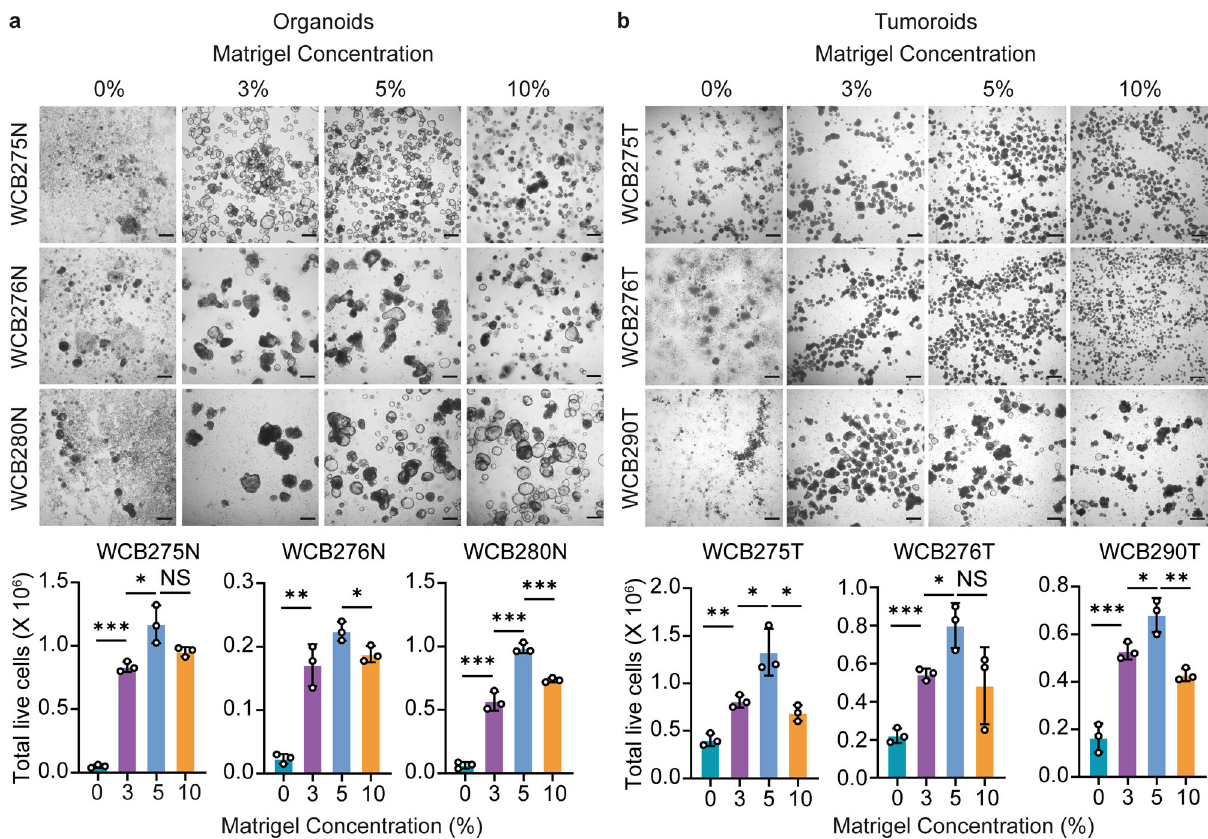
Fig. 1 Low-percentage, low-viscosity Matrigel for suspension culture of patient-derived colorectal organoids and tumoroids. a – b Representative bright- fi eld images and quanti fi cation of live-cell yield for ( a ) organoids and ( b ) tumoroids from three patients grown from single cells in media supplemented with 0, 3, 5, or 10% of Matrigel matrix (25,000 cells, 1 ml of medium/well) over a 14-day incubation period; scale bars, 200 μ m. Data are plotted as mean ± s.d. Statistical signi fi cance was attributed to values of p < 0.05 as determined by the Student ’ s t test. NS, p > 0.05, * p < 0.05, ** p < 0.01, *** p < 0.001. N normal, T